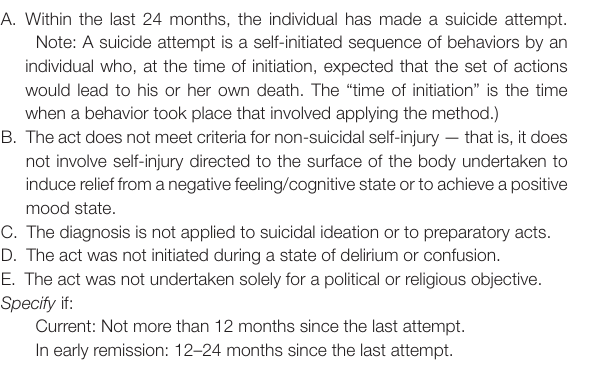
TABLE 1 | The diagnostic criteria for suicidal behavior disorder (SBD), according to the DSM-5 (Section III, Conditions for Further Study) (11). A. Within the last 24 months, the individual has made a suicide attempt. Note: A suicide attempt is a self-initiated sequence of behaviors by an individual who, at the time of initiation, expected that the set of actions would lead to his or her own death. The “time of initiation” is the time when a behavior took place that involved applying the method.) B. The act does not meet criteria for non-suicidal self-injury — that is, it does not involve self-injury directed to the surface of the body undertaken to induce relief from a negative feeling/cognitive state or to achieve a positive mood state. C. The diagnosis is not applied to suicidal ideation or to preparatory acts. D. The act was not initiated during a state of delirium or confusion. E. The act was not undertaken solely for a political or religious